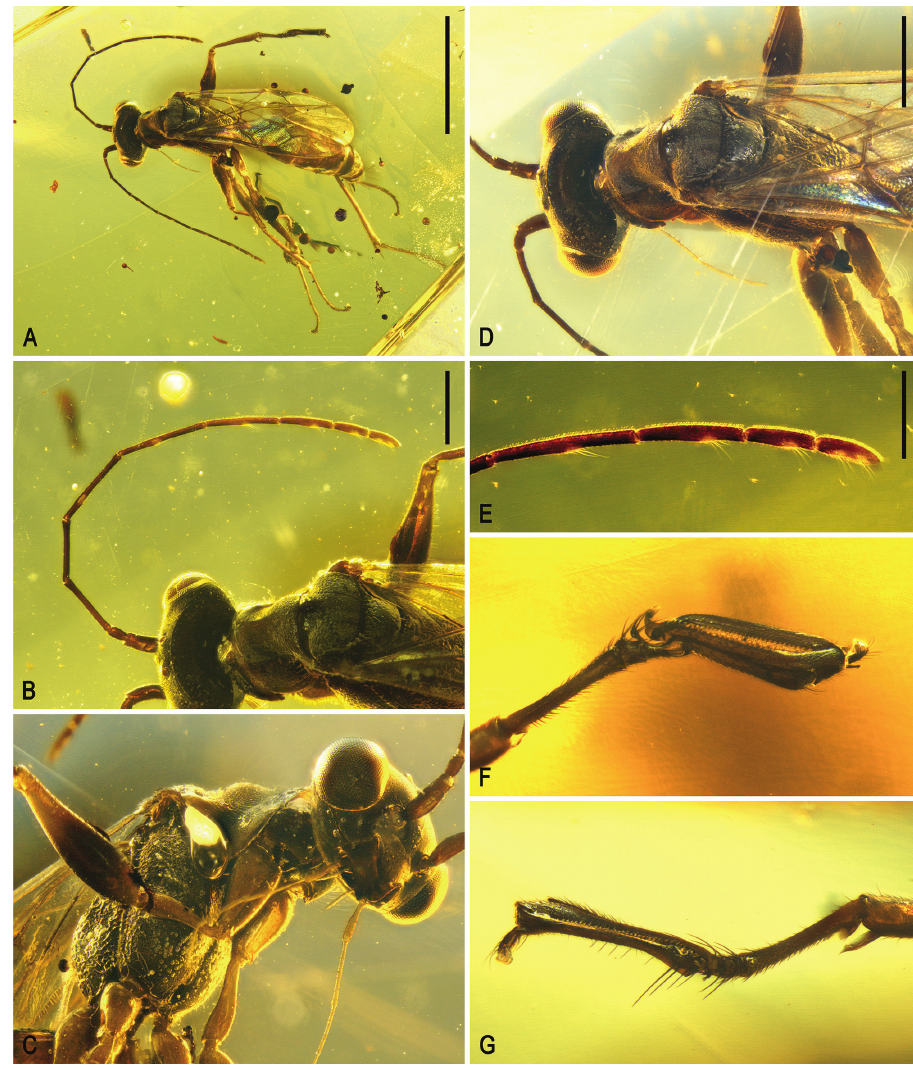
Figure 1. † Thaumatodryinus fuscescens sp. nov., female holotype. A habitus, dorsal view B right antenna, dorsal view C head and mesosoma, antero-ventral view D head and mesosoma, dorsal view E apical por- tion of flagellum, with details of flagellomeres 5–8 F–G Apical portion of fore leg, with details of the chela. Scale bars: 2 mm ( A ), 0.5 mm ( B ), 0.5 mm ( C–D ), 0.3 mm ( E–G